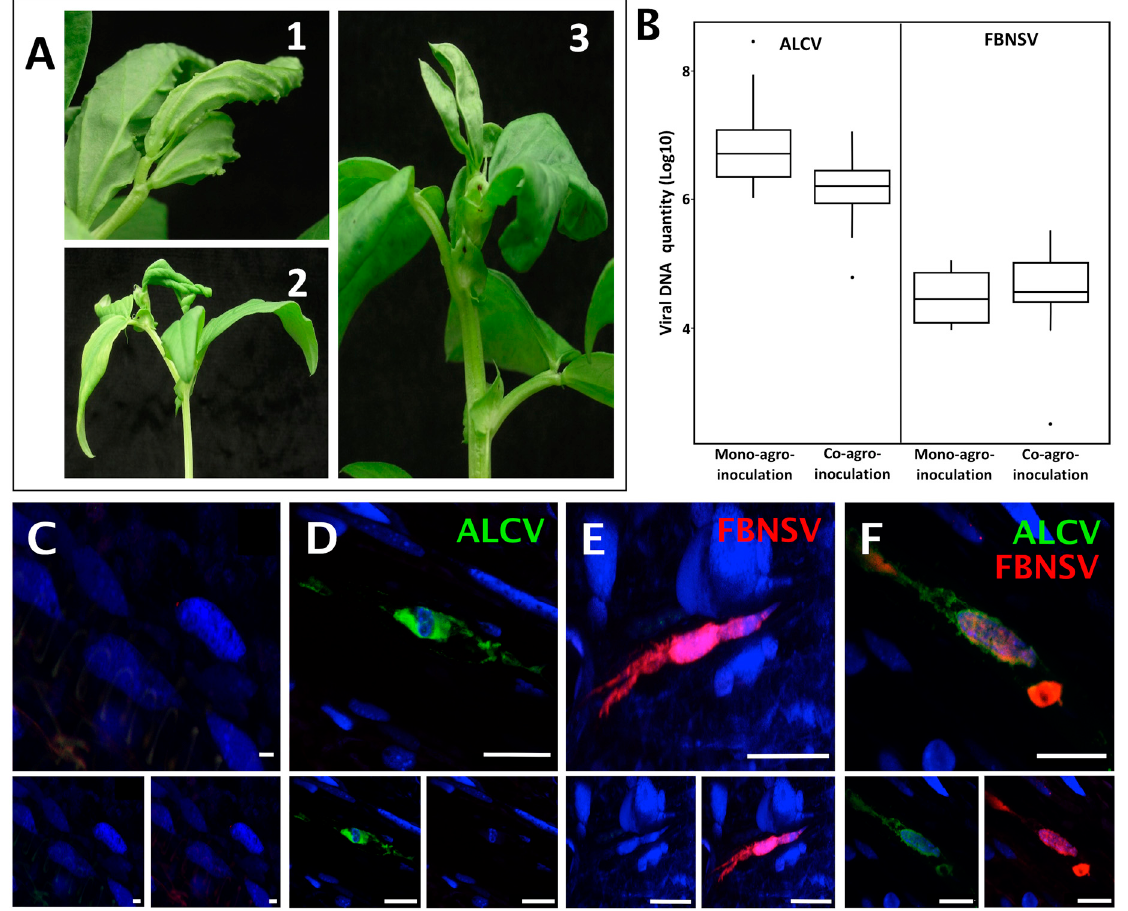
Figure 1. Localization of FBNSV and ALCV DNA in broad bean host plants. Visualization of ALCV symptoms ( A1 ) and FBNSV symptoms ( A2 ) on late stage of infection on broad bean plants, where symptoms are easier to see, and ALCV + FBNSV symptoms ( A3 ) on early stage of infection, when over-curling of leaves due to FBNSV do not yet totally mask ALCV-associated vein swelling. ( B ) Box-plots of viral DNA amounts (log10 of the copy number, see Materials and Methods) of each virus in mono- and co-agro-inoculated broad bean plants. The box-plot on the mono- and co-infected plants represent n = 9 for FBNSV, n = 11 for ALCV and n = 15 for co-infected plants, respectively. C to F: Localization of ALCV DNA (green probe) and FBNSV DNA (8 segments labeled, red probe) in phloem tissues of broad bean plants either mock infected ( C ), or co-infected with the two viruses ( D – F ). Most cells contain either ALCV ( D ) or FBNSV ( E ) alone, but they can also occasionally be co-infected ( F ). Top panel in C to D are images with merged color channels and the corresponding split channels are at the bottom left (green) and right (red). Each image corresponds to maximum intensity projections. The scale bar of each image represents 25 µ m. Cell nuclei are DAPI